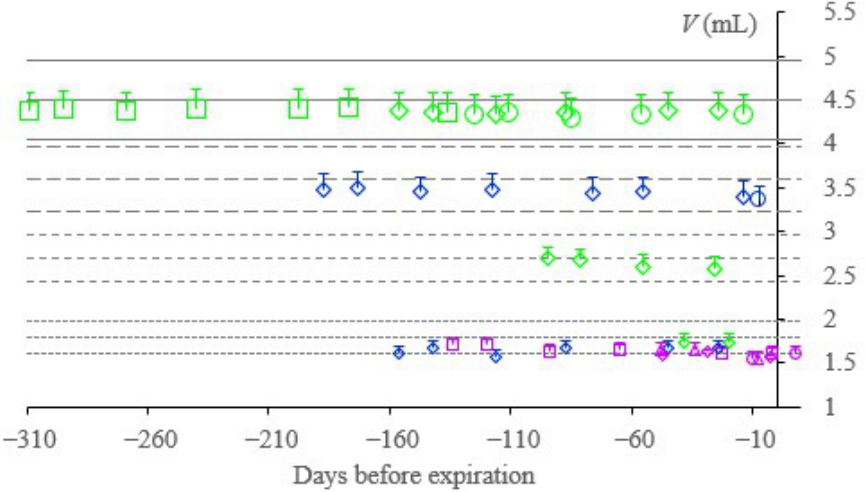
Figure 4. Draw volumes determined in Ljubljana at 300 m altitude, at ambient temperature during a life-cycle of the tubes; the error bars indicate the draw volume as assumed to be at 1013 hPa and 20 °C; the violet, blue, and green markers pertain to the tubes A, B, and C; the horizontal lines of a particular type define the 10% range around the target draw volume.